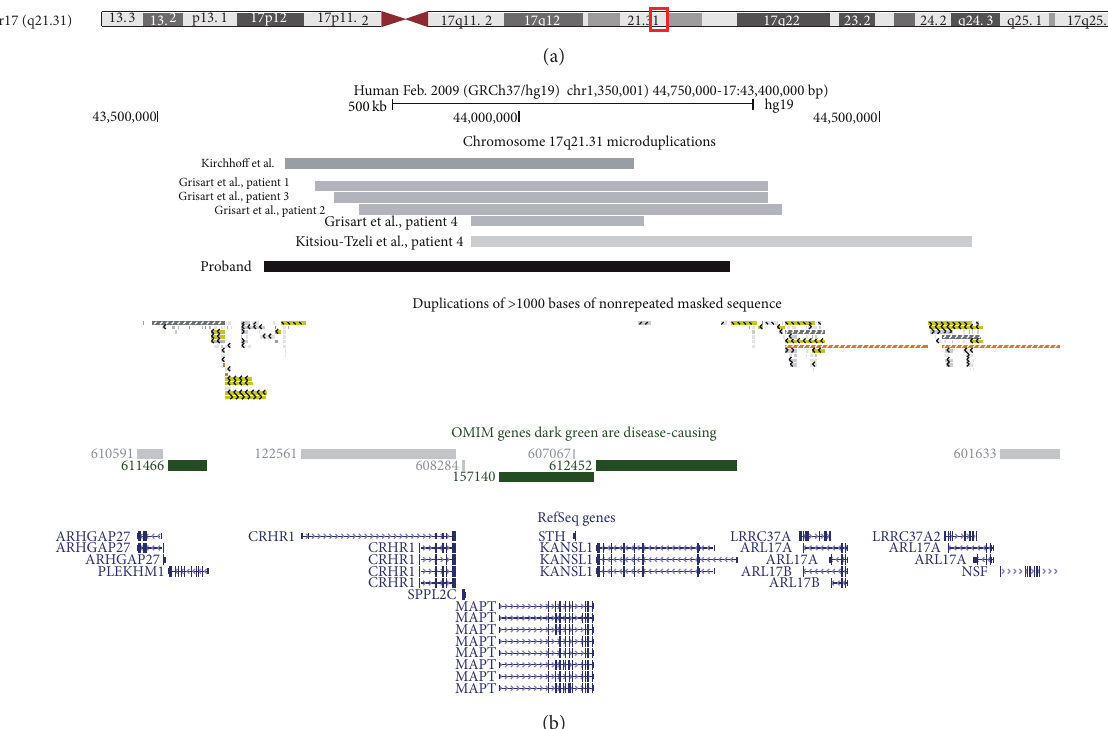
Figure 1: Schematic of the chromosome 17 region containing the microduplication. Panel A shows an ideogram of chromosome 17, together with the region encompassing the microduplications. Panel B shows the location and extent of the duplications detected in the proband reported here, other cases reported in the literature, LCRs (segmental duplications), and OMIM and Refseq genes that lie within the microduplicated region. These graphics were taken from the UCSC genome browser (http://genome.ucsc.edu/).